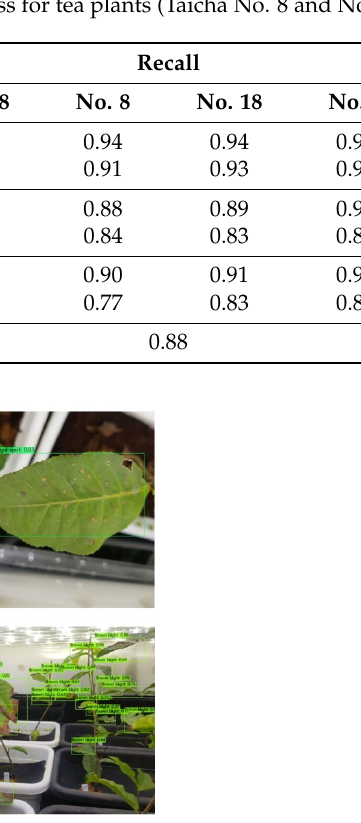
Table 3. Performance evaluation of each class for tea plants (Taicha No. 8 and No. 18).